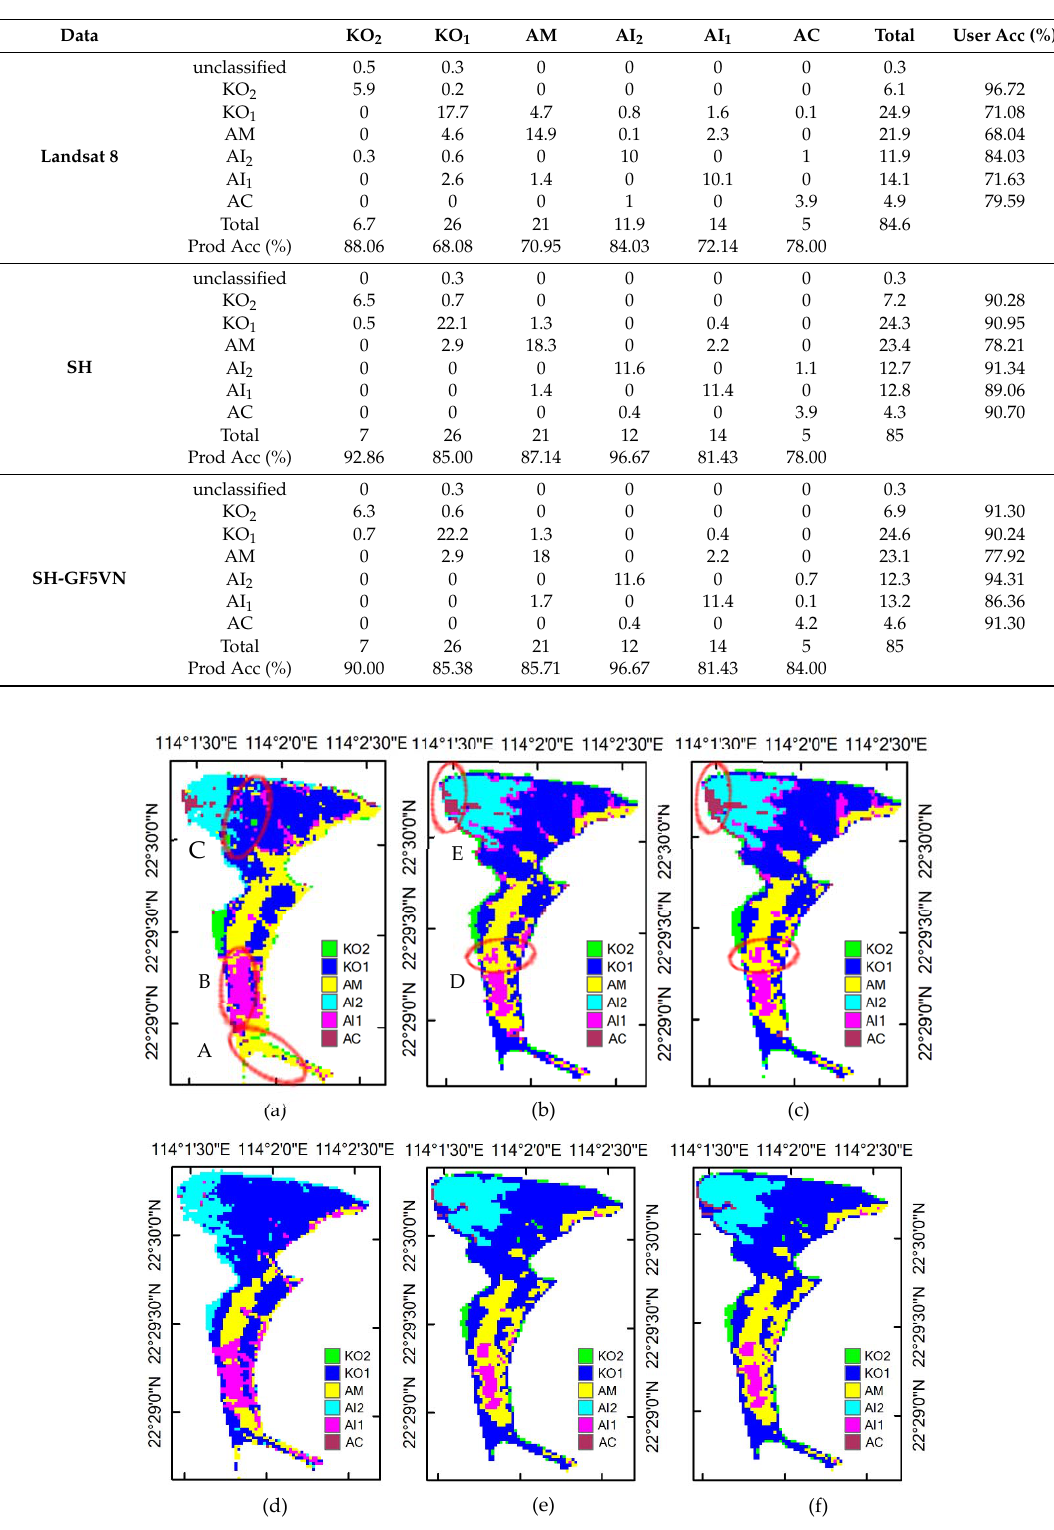
Table 6. The mean confusion matrix of mangrove species mapping using Random Forests with di ff erent datasets.